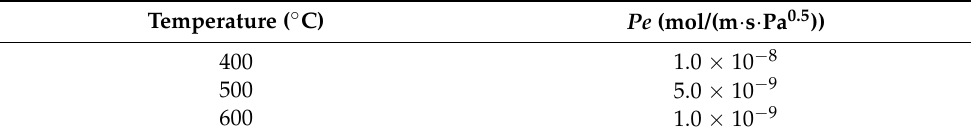
Table 9. Pe of Pd/Cu membrane used in this study